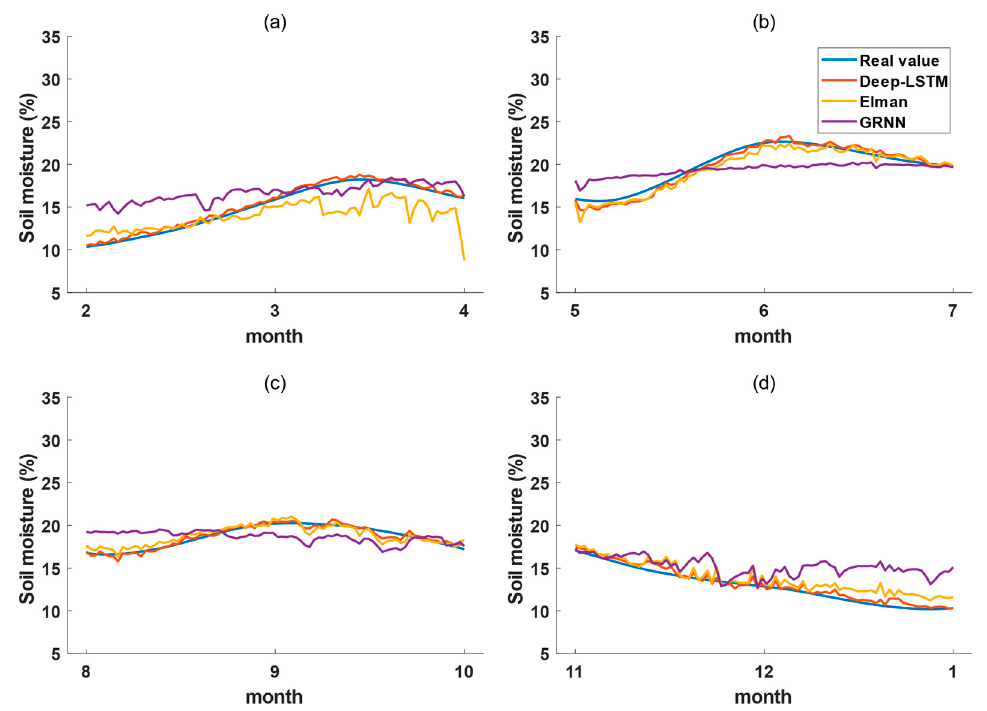
Figure 8. Comparison of the predicted and measured soil moisture percentages of the three models in the four different growth seasons. ( a ) season 1 results; ( b ) season 2 results; ( c ) season 3 results; ( d ) season 4 results.